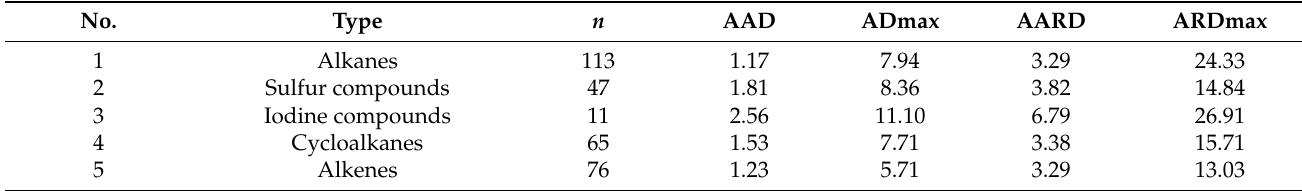
Table 5. Classification and summary of prediction results by B-P